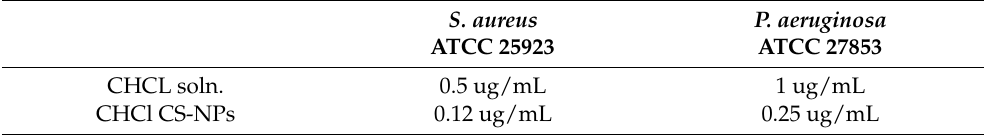
Table 11. MIC values for two bacterial